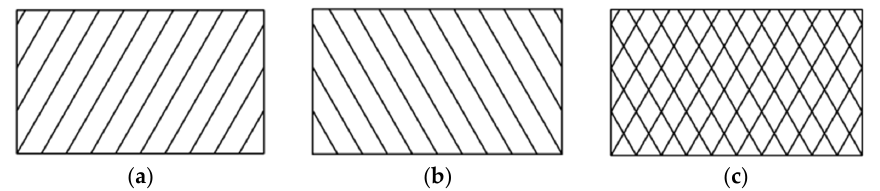
Figure 1. The schematic of laminate composite layers: ( a ) θ ° layer; ( b ) −θ ° layer; ( c ) θ °/ −θ ° laminate composite layer.